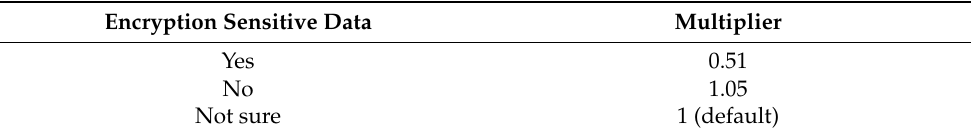
Table 10. Cost factor—sensitive data encryption F Encryption